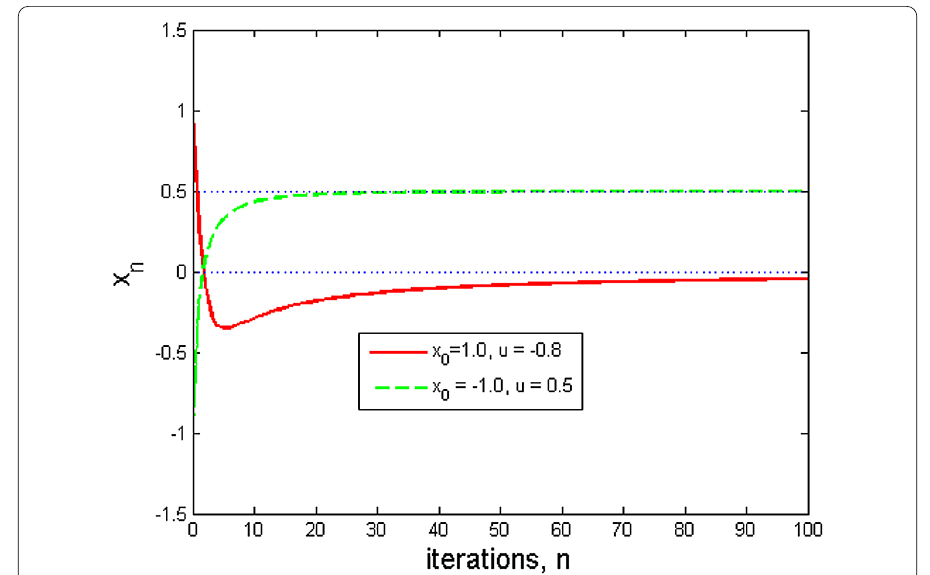
Figure 1 Convergence of x n with different values of x 0 and